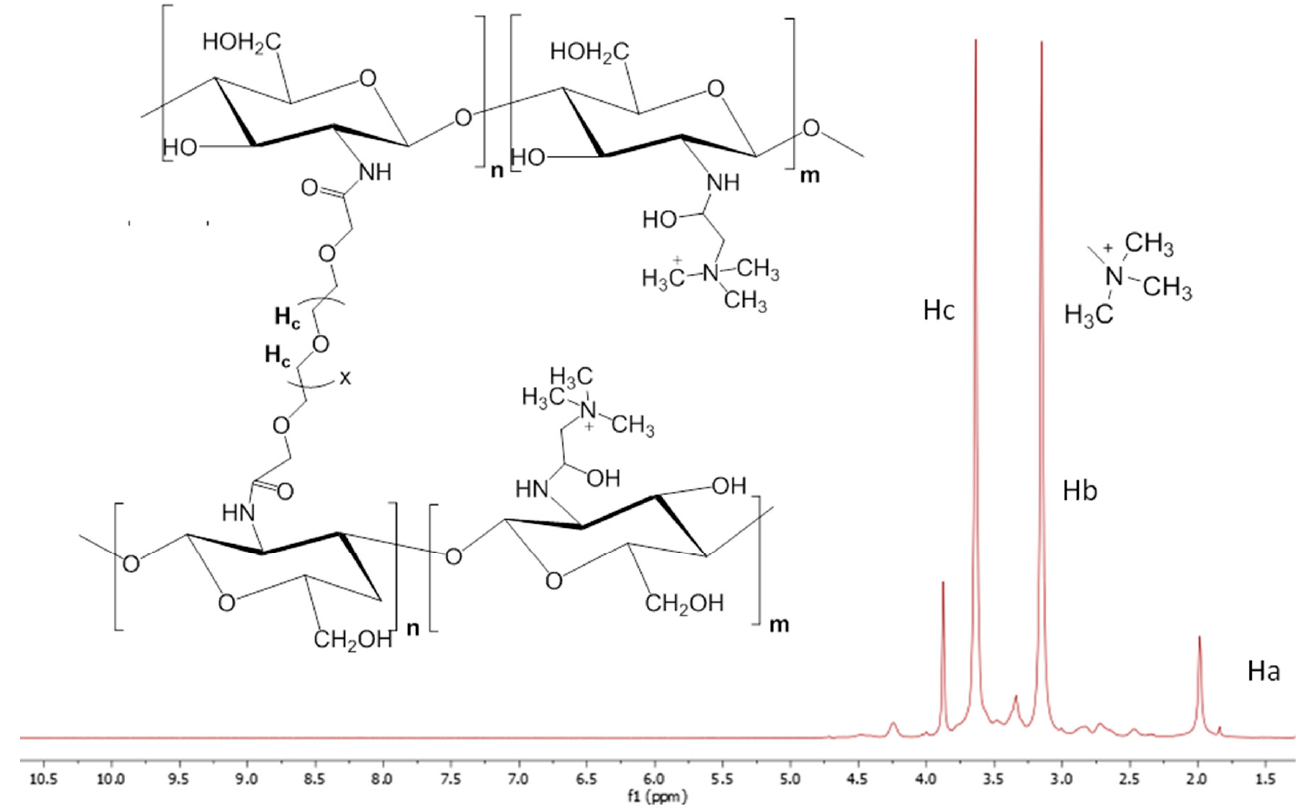
Figure 6. 1 HNMR spectrum of the quaternized chitosan nanogels.